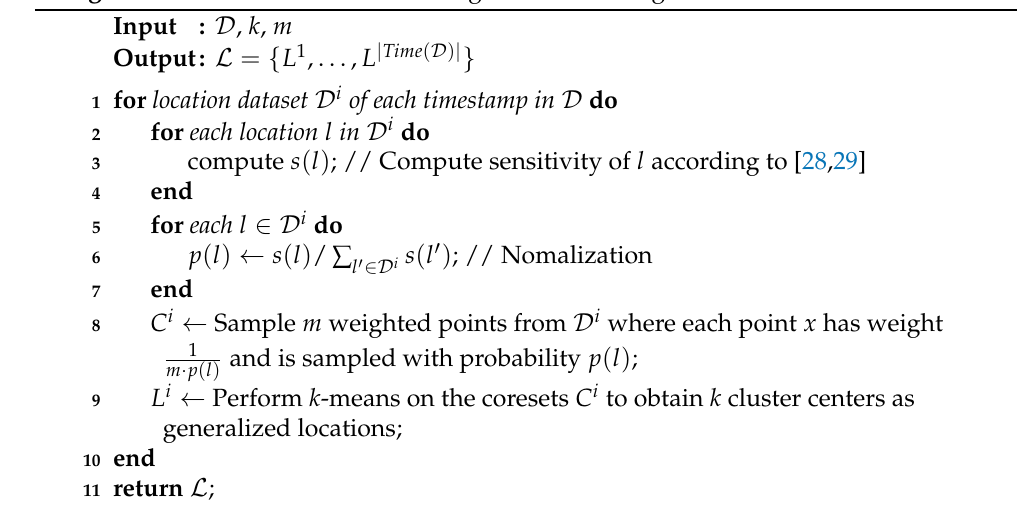
Algorithm 1: coresets based location generalization